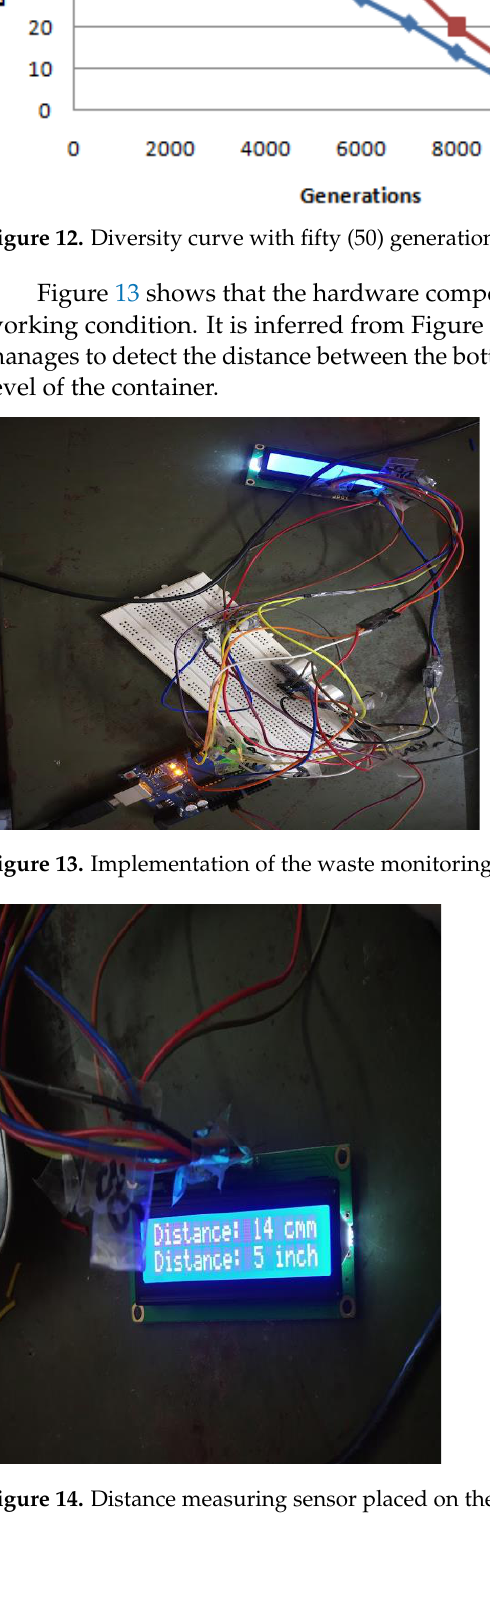
Figure 11. Diversity curve with thirty (30) generations.